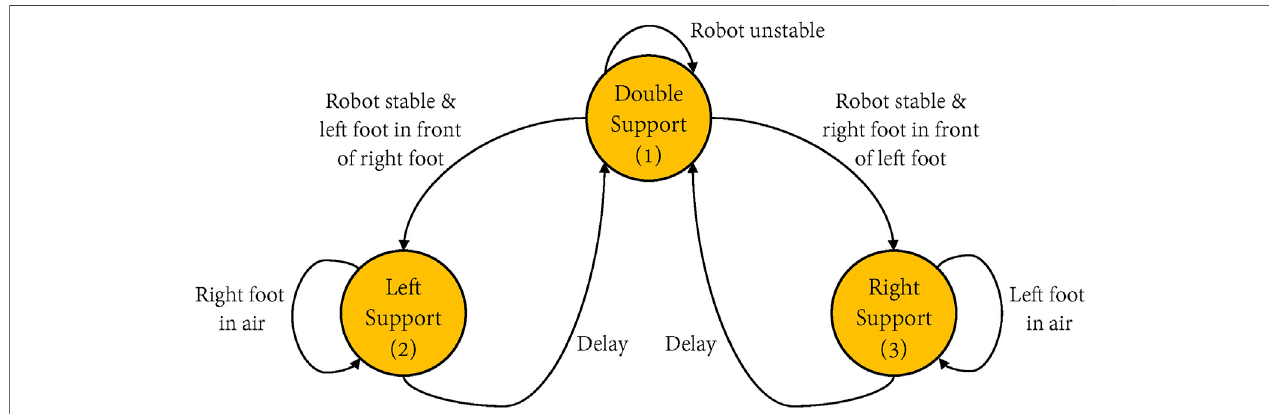
FIGURE 3 | The fi nite state machine in the bipedal walking algorithm. There are three states during the walking cycle to allow transitions of different virtual components.The fi rststateisthedoublesupport,whichmeansbothfeetarecontactingthe fl oor,andthesecondstateofleftsupportmeansonlytheleftfootcontacting the fl oor.Similarly,thethirdstaterightsupportonlyhastherightfootonthe fl oor.Thearrow indicatestheconditionsthatneedtobemetforthetransition. “ Delay ” means the delay time to allow for the swing leg tofall to the ground, so that the single support phase can transit to the doublesupport phase. “ Stable ” means the creature has the possibility to walk forward, while in our work, we set a velocity threshold parameter stableTolerance to decide whether the angular velocity of the hip, the knee, and the ankle are smaller than the threshold. If they are all smaller than the velocity threshold, this situation is stable.